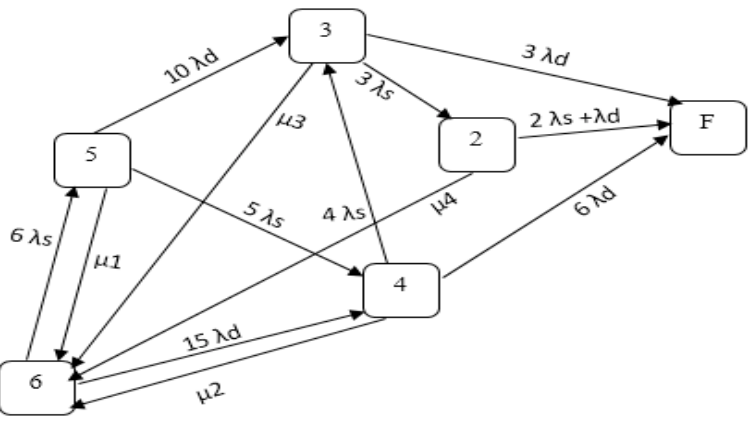
Figure 3. 6MR Markov model.